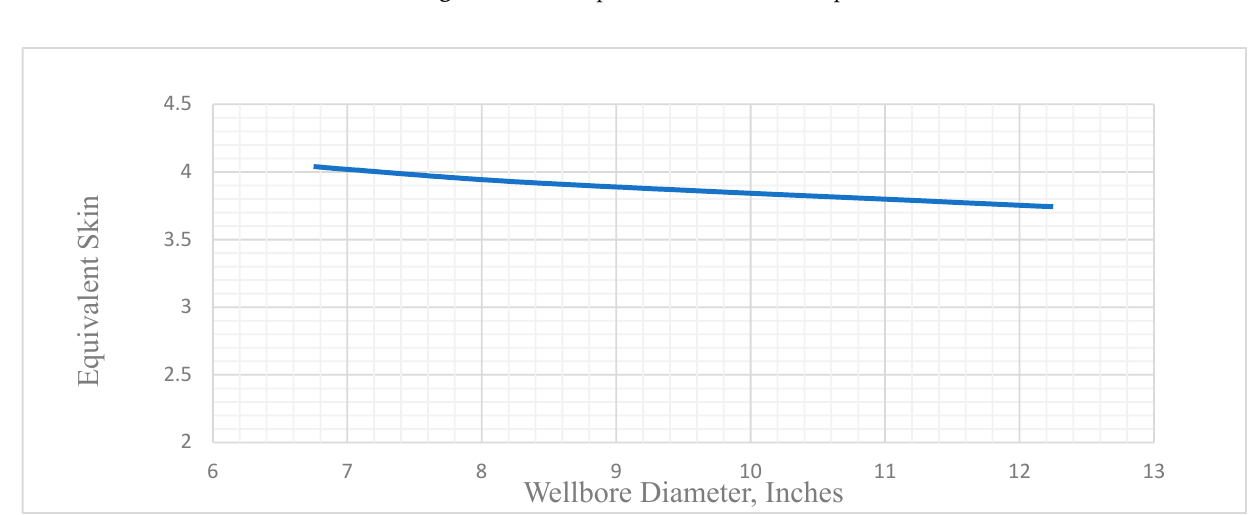
Figure 14. Equivalent skin factor versus wellbore diameter.